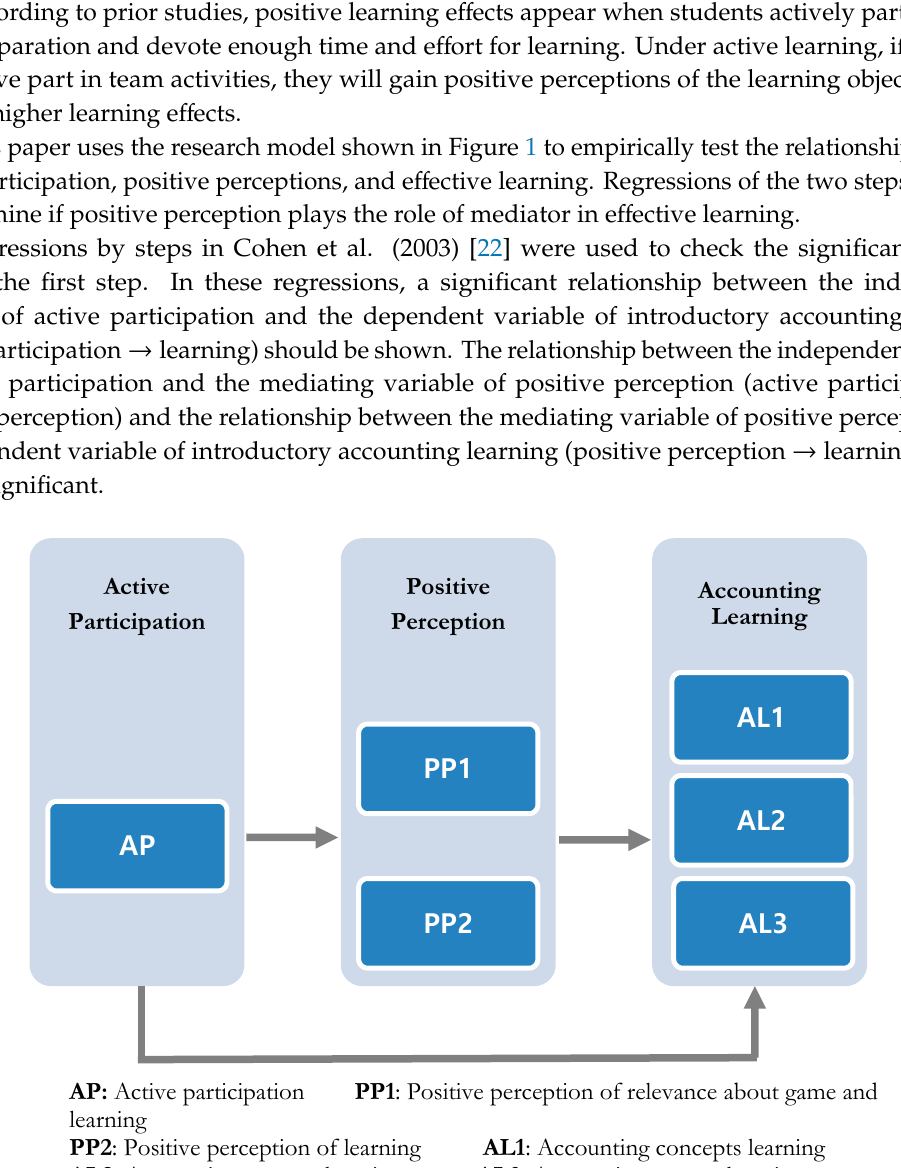
Figure 1. Research Figure 1. Research model.